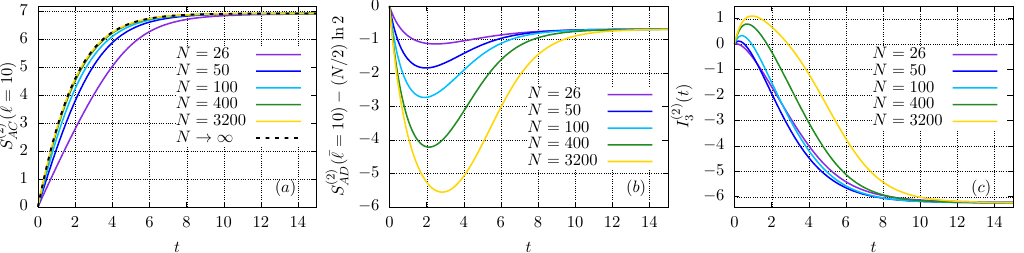
Figure 8 . Sub(cid:12)gure ( a ): time evolution of the R(cid:19)enyi-2 entropies S (2) for the subsystem A C , as AC [ displayed in (cid:12)gure 2, with (cid:22) ‘ = 10. Solid lines correspond to increasing values of N (from bottom to top), while the black dashed line is the analytic prediction (4.11). Sub(cid:12)gure ( b ): time evolution of the R(cid:19)enyi-2 entropy S (2) for the subsystem A D , with (cid:22) ‘ = 10. Note that S (2) is shifted AD AD [ by its maximum value ( N= 2) ln 2. Solid lines correspond to increasing values of N (from top to bottom). Sub(cid:12)gure ( c ): time evolution of the R(cid:19)enyi-2 tripartite information I (2) ( A : C : D ), for 3 the bipartitions A B , C D displayed in (cid:12)gures 2 and 3 , with (cid:22) ‘ = 10. Solid lines correspond to [ [ increasing values of N (from bottom to